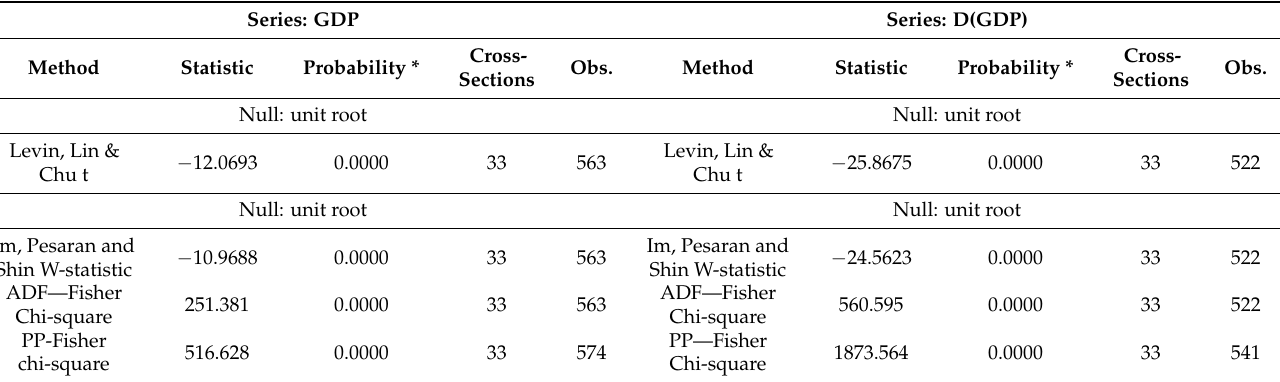
Table 4. Panel unit root